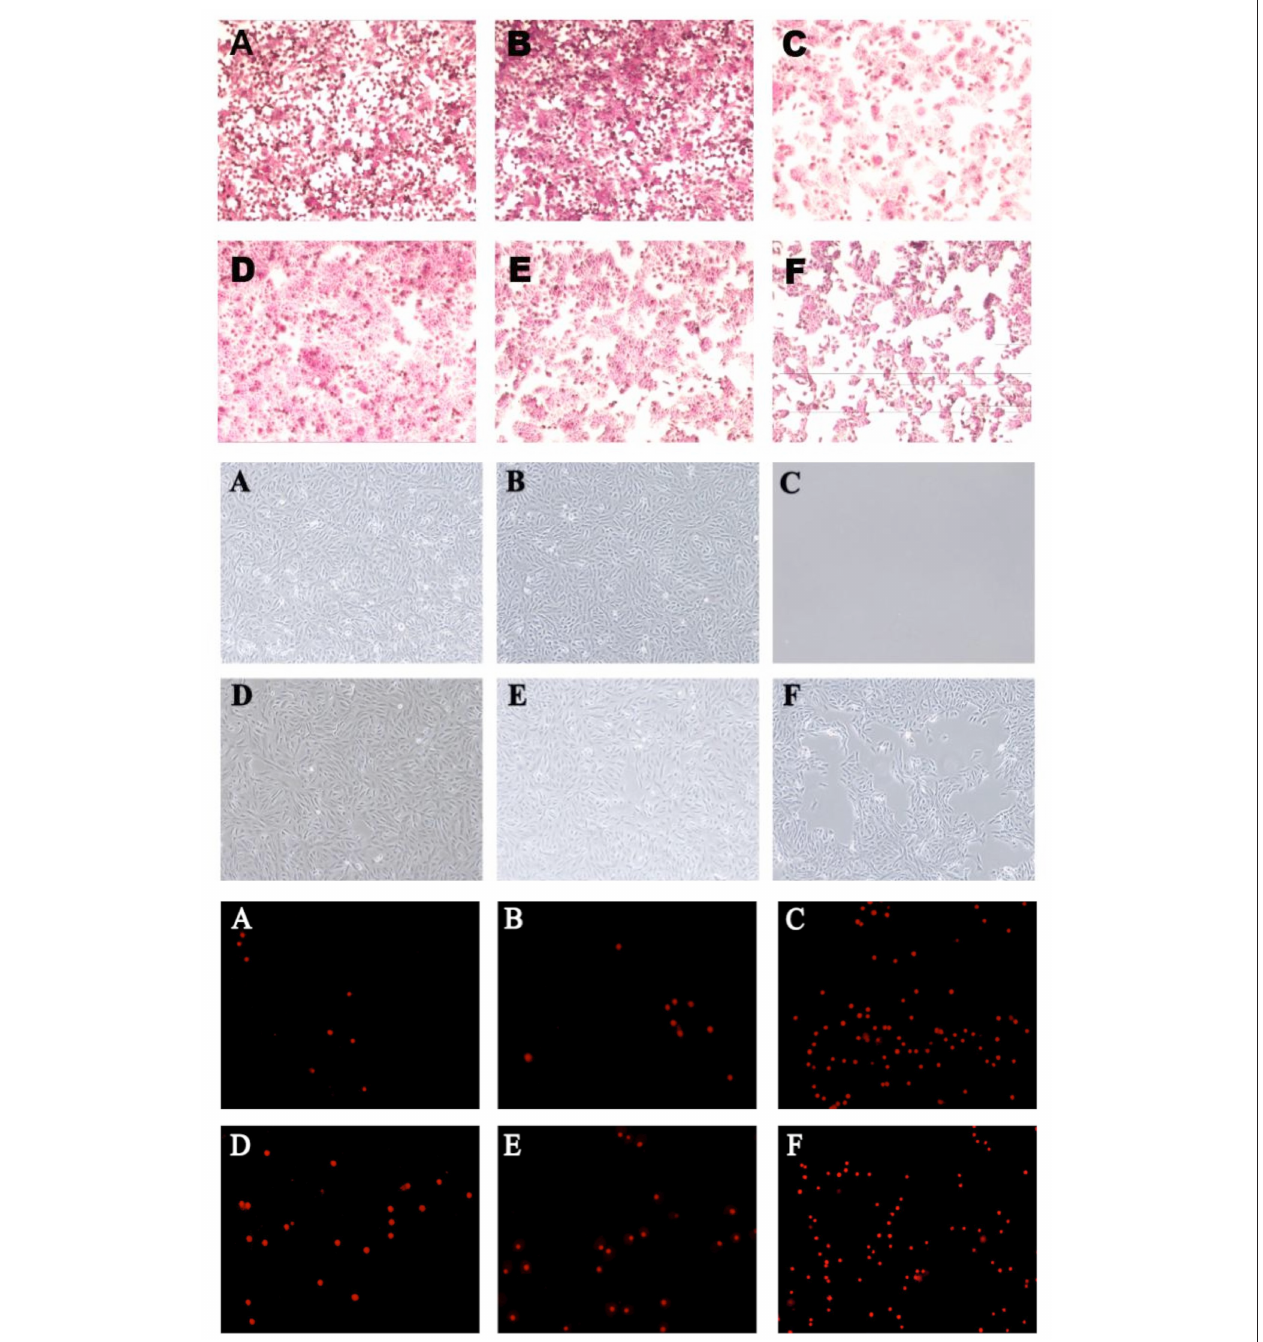
Supplementary Figure 3 | B. fragilis ZY-312 inhibits colon cell apoptosis induced by C. difficile . Representative images of PAS staining (top) for Muc-2 protein visualization in HT-29 cell monolayers are shown for all groups. Microscopic observations (middle) of Vero cell morphology and viability and PI staining (bottom) of Vero cells in all groups are shown. (A) Blank control group, 5 × 10 5 HT-29 or Vero cells were cultured without treatment; (B) B. fragilis group, cells were incubated with 5 × 10 8 cfu B. fragilis ; (C) C. difficile group, cells were incubated with 5 × 10 7 cfu C. difficile ; (D) Exclusion group, cells were infected with 5 × 10 8 cfu B. fragilis for the first hour and 5 × 10 7 cfu C. difficile for the second hour; (E) Competition group, cells were co-infected with B. fragilis and C. difficile ; (F) Substitution group, cells were infected with C. difficile for the first hour and B. fragilis for the second hour. The cells were incubated at 37 ◦ C under anaerobic conditions for 2h in total.